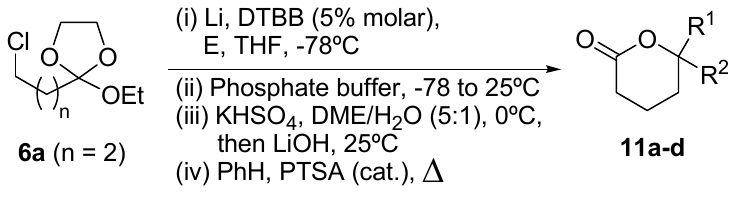
Table 2. Preparation of δ -lactones 11 from ortho ester